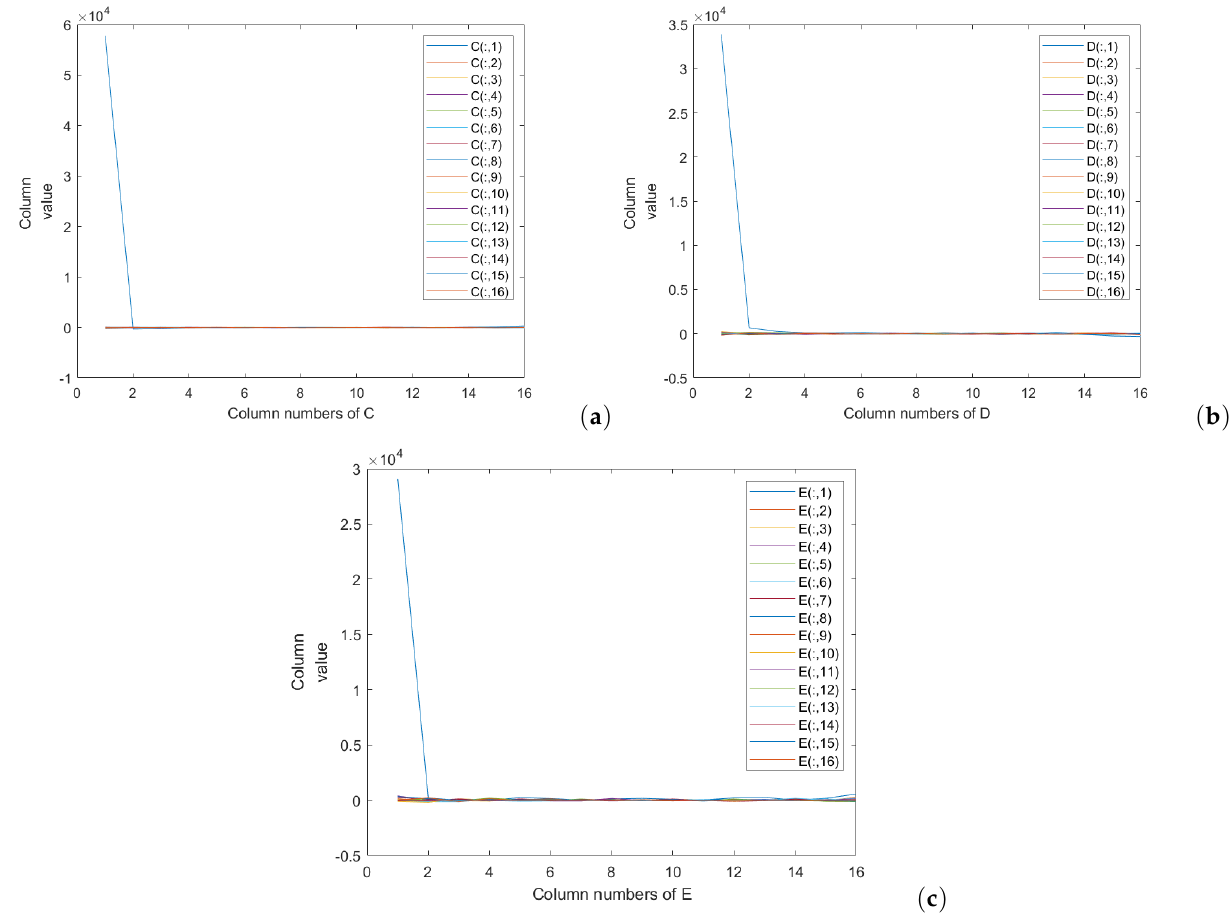
16. ( b ) The D (cid:48) s × ×